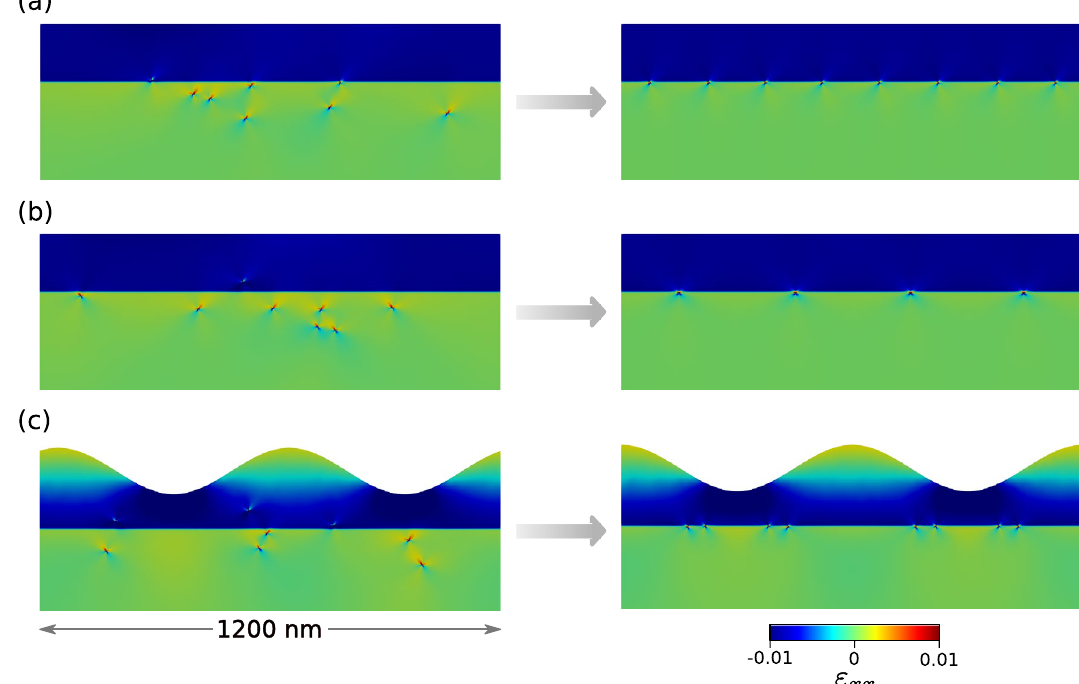
Figure 3. Example of low energy configurations obtained by minimum searches (right) starting from random initial configurations (left). Colormap indicates the xx component of strain field. As expected, regular arrays of 60 ◦ ( a ) or edge dislocations ( b ) are observed. When the free surface is perturbed, edge dislocation formation is inhibited ( c ) and defects place below valleys in the surface